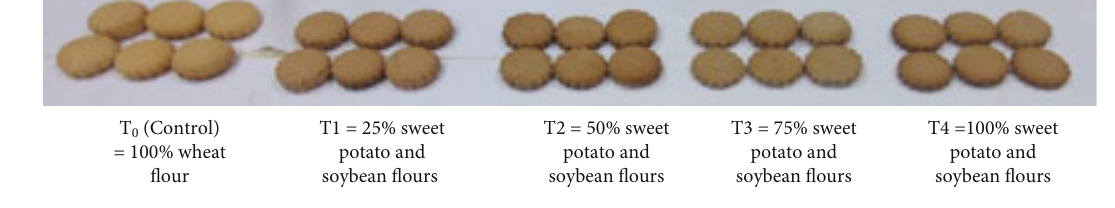
Figure 1: Di ff erent biscuits produced. Table 4: Sensory evaluation of biscuits.